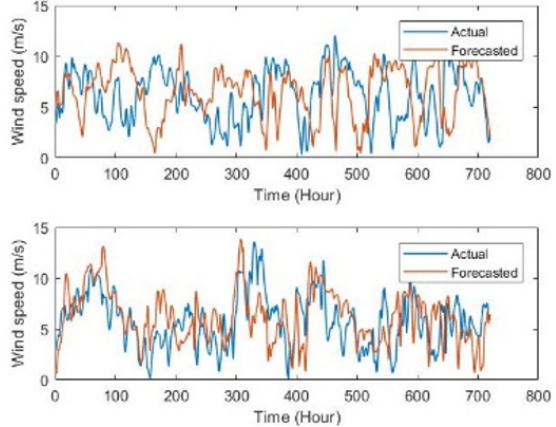
Figure 18. Forecasted and actual wind speeds of 2017, Jan. & Feb. Jubail, Case III.